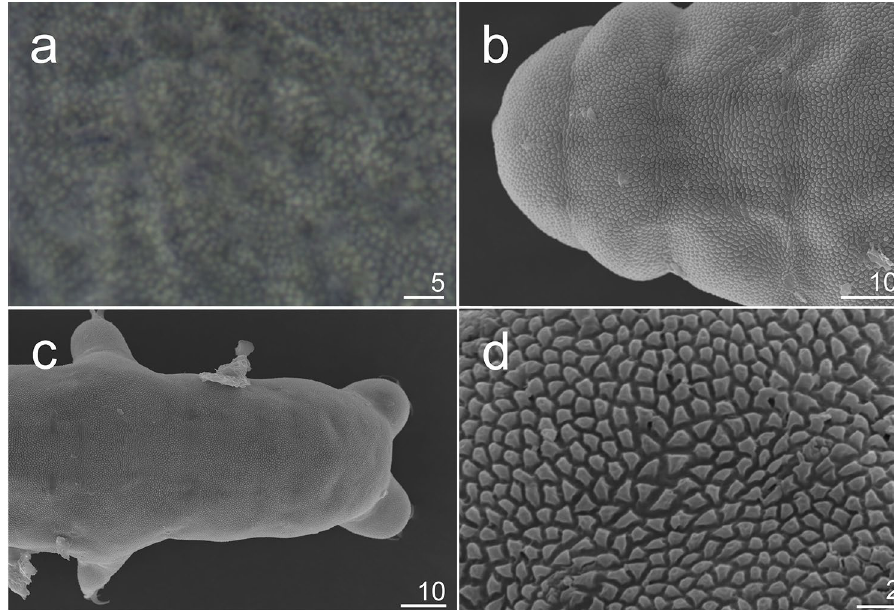
Figure 4. Hypsibius nivalis sp. nov., cuticular sculpture: ( a ) dorsal view, paratype (PCM), ( b ) dorsal view, cephalic part, paratype (SEM), ( c ) dorsal view, caudal part, paratype (SEM), ( d ) dorsal view, granular and separated polygons, paratype